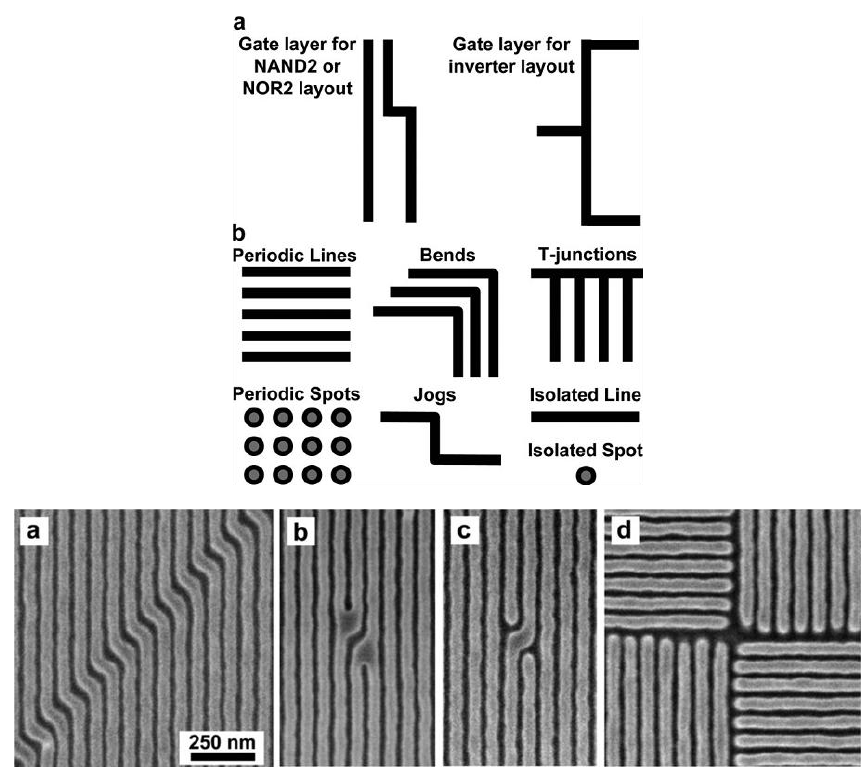
Figure 6. Common lithographic patterns for microelectronics and realization of some